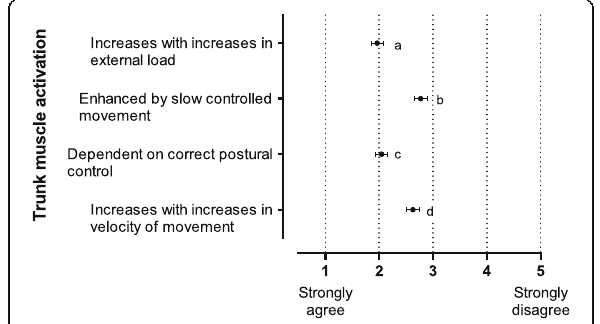
Fig. 4 Responses to a series of statements relating to ground-based loaded free barbell exercises and trunk muscle activation. Data are reported as mean level of agreement with 95% CI. 1 = strongly agree, 5 = strongly disagree. Significant differences p < 0.001: a vs b, a vs d, b vs c, c vs d. CI: confidence interval